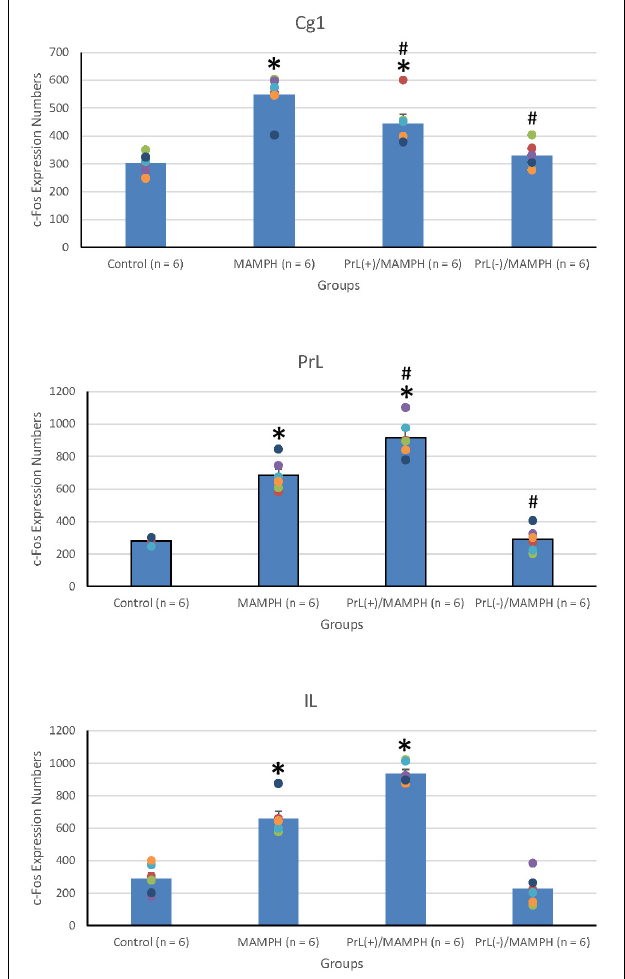
FIGURE 5 | MAMPH administrations were tested to label c-Fos expression in the Cg1, PrL, and IL of the mPFC for the control ( n = 6), MAMPH ( n = 6), PrL(+)/MAMPH ( n = 6), and PrL(–)/MAMPH groups ( n = 6) by injecting NMDA or saline into the PrL. PrL(+): injection of a low concentration of NMDA to excite the PrL neurons; PrL(–): injection of a high concentration of NMDA to destroy the PrL neurons. Differences in c-Fos expression levels in the Cg1, PrL, and IL among all groups were analyzed by one-way ANOVA, followed by Tukey’s post hoc test if a significant difference was appeared among groups. ∗ p < 0.05 indicates significant differences compared with the control group; # p < 0.05 indicates significant differences compared with the MAMPH